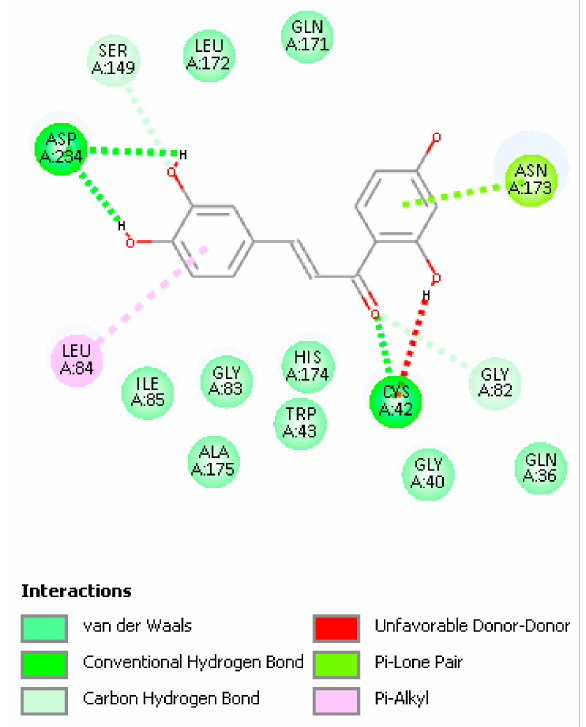
Figure 19. 2D interactions between pose 1 Butein and the active site of falcipain-2. Unfavored Butein H(hydroxyl) in position 2 (cid:48) suggests a potential break of the O(carbonyl)–H2 (cid:48) H